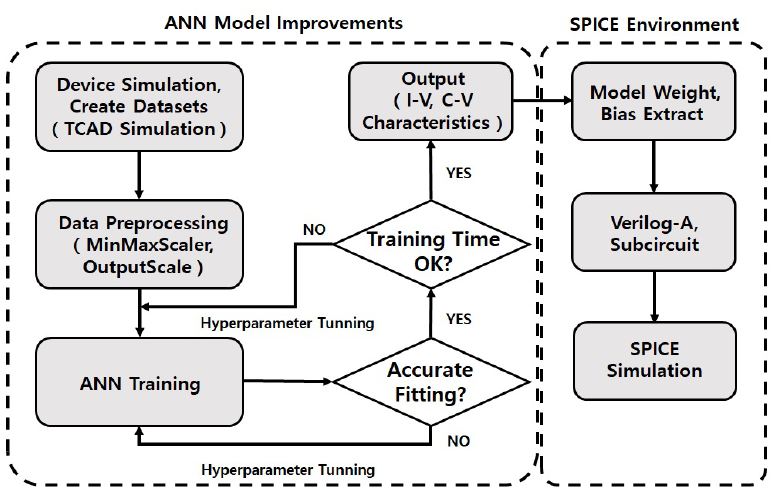
Figure 6. The workflow of the ANN model.